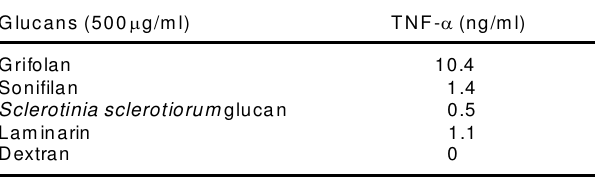
Table 1. Effect of various glucans on tumor necrosis factor (TNF)- a production by macrophages in vitro . RAW264.7 cells were cul- tured with several concentrations of glucans for 24 h at 37 ° C in a humidified CO